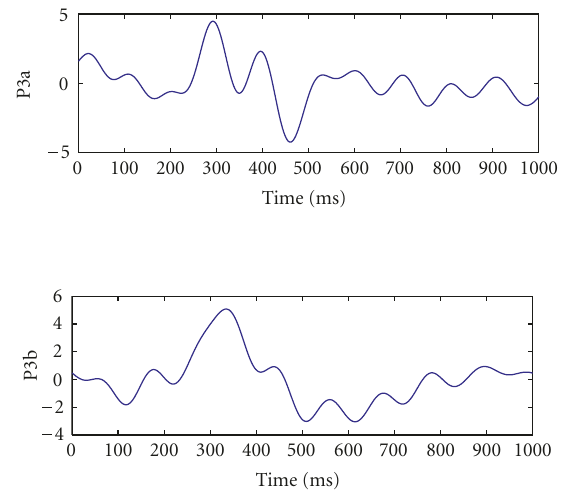
Figure 10: The separated P3a and P3b from the signals of Figure 9 using the proposed CBSS algorithm.